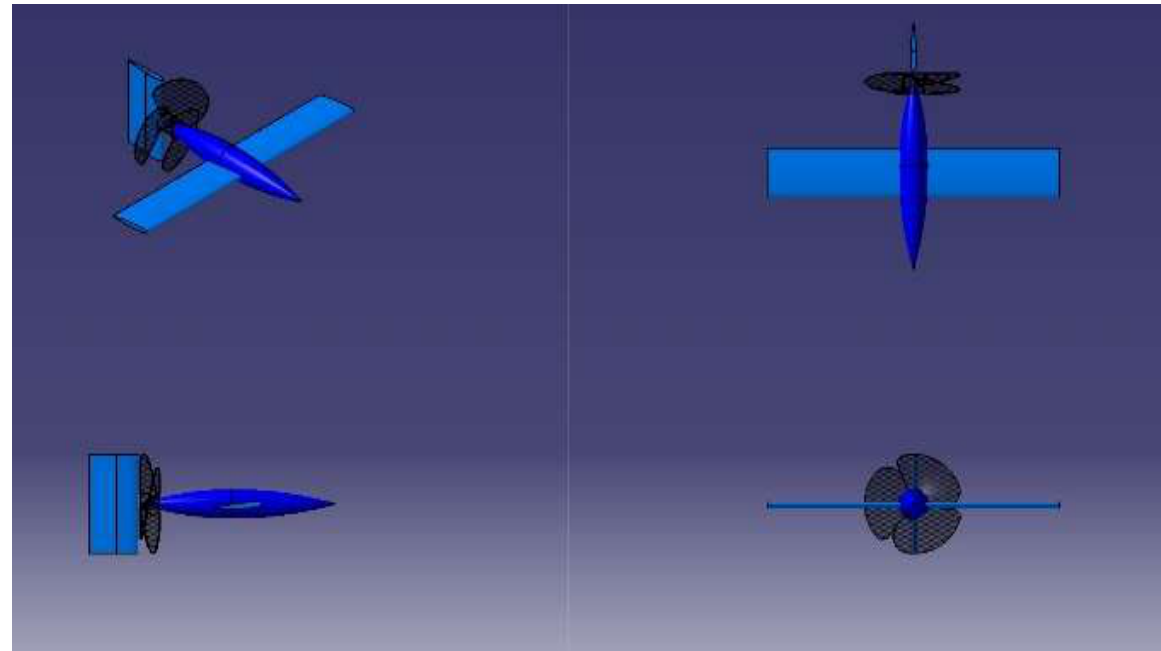
Figure 8. The multi-view of US at climb and above the water surface flight.